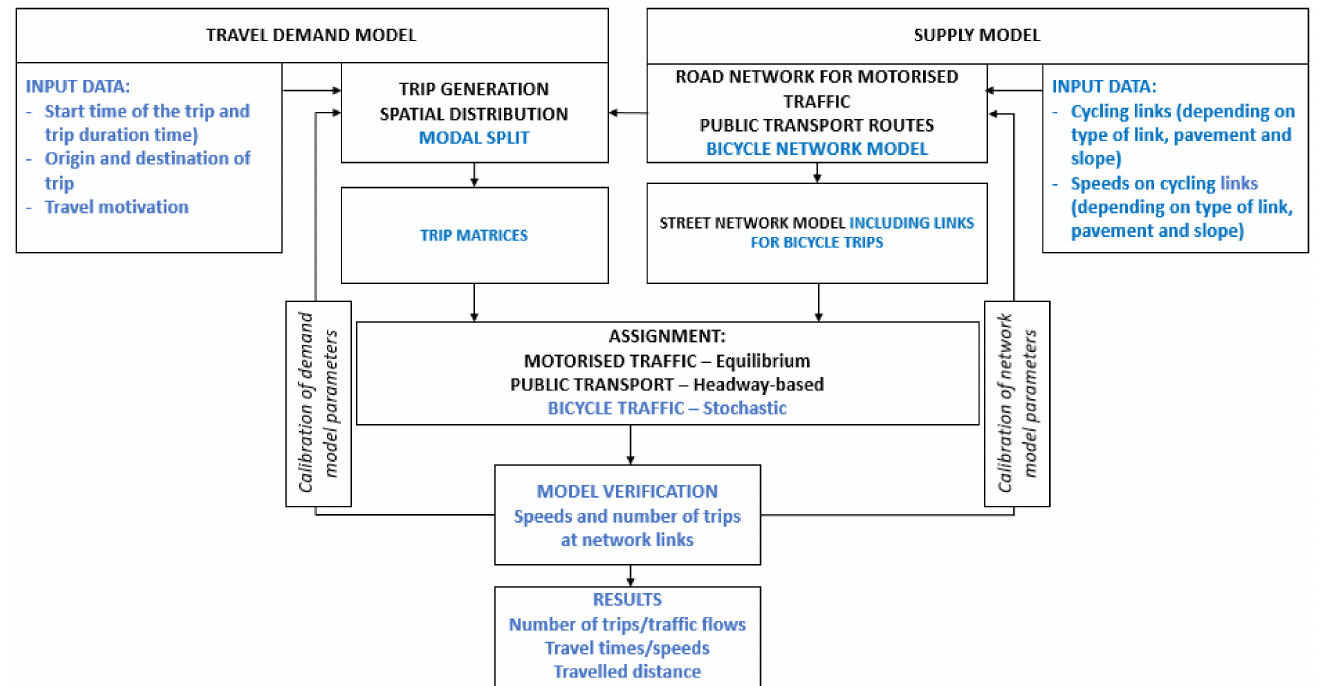
Figure 1. Integration of the bicycle traffic model into the